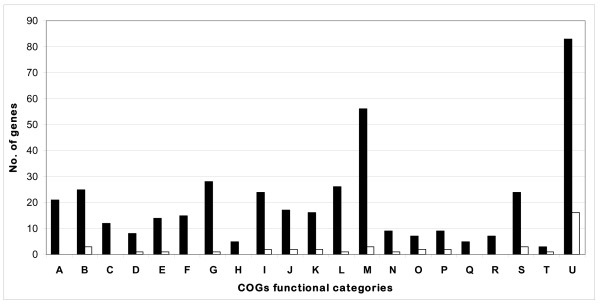
Distribution of genes differentially expressed at late-log growth phase compared to stationary phase associated in cluster of ortholog genes (COGs) functional categories. Functional classifications are as follows: A, DNA replication, recombination and repair; B, Transcription; C, Translation, ribosomal structure and biogenesis; D, Nucleotide metabolism; E, Carbohydrate metabolism; F, Lipid metabolism; G, Amino acid metabolism; H, Secondary metabolites biosynthesis, transport and metabolism; I, Energy production and conversion; J, Inorganic ion transport and metabolism; K, Cofactor transport and metabolism; L, Cell envelope, biogenesis and outer membrane; M, Membrane transport; N, Defense mechanism; O, Signal transduction; P, Post-translational modification and secretion, protein turnover and chaperones; Q, Cell division; R, Cell motility and chemotaxis; S, General function prediction only; T, Predicted by homology; U, Unknown function. Solid bars, up-regulated genes; open bars, down-regulated genes.